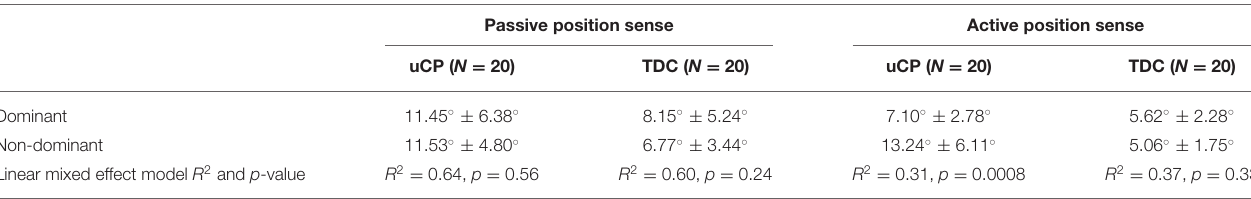
TABLE 2 | Comparison of dominant and non-dominant hands in uCP and